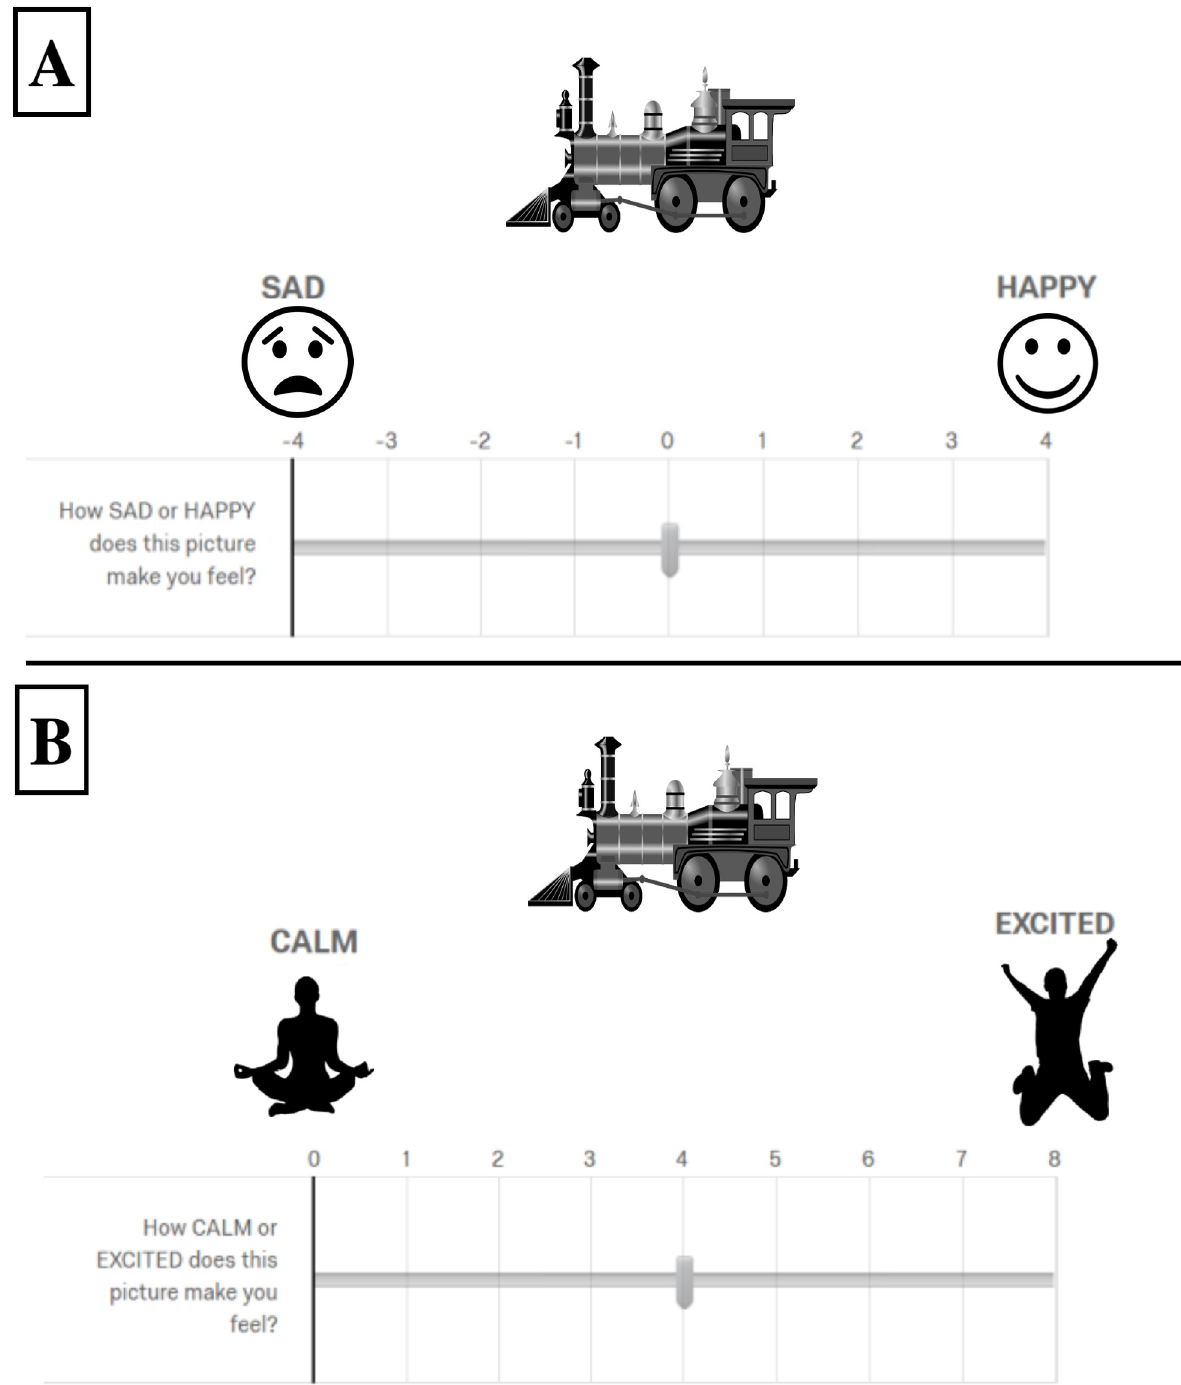
Fig 9. Experiment 2 procedure. A: Participants rated the valence of the stimuli by indicating how sad versus happy each stimulus made them. Valence ratings could vary from -4 (sad) to +4 (happy). B: Participants rated their level of arousal in response to the stimuli by indicating how calm versus excited each stimulus made them. Arousal ratings could vary from 0 (calm) to 8 (excited). The trials were self-paced. Note: Due to copyright restrictions, many of the images in this figure are representative. See S1 File for information on how to access the actual images used in the